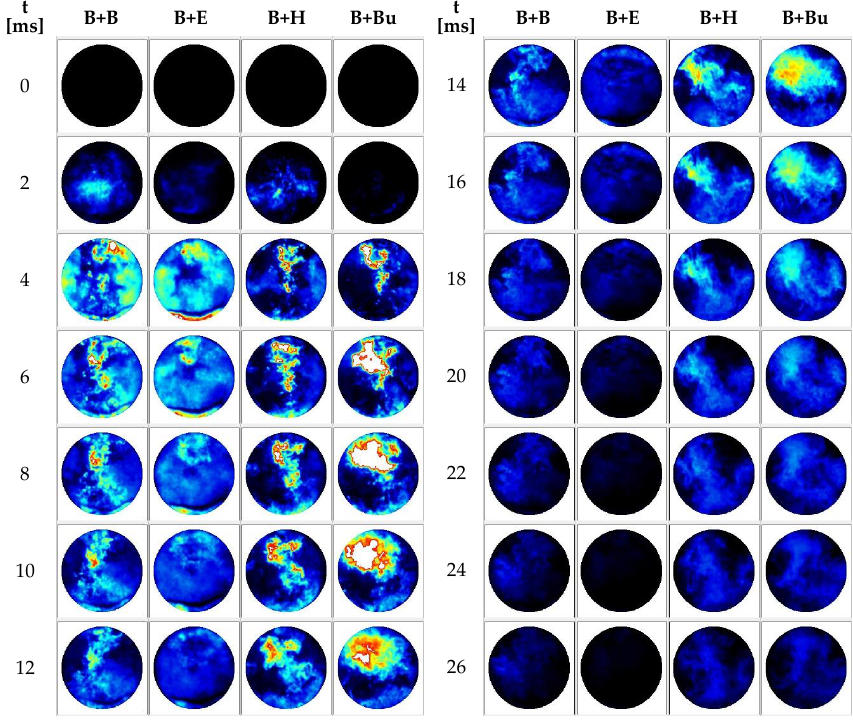
Figure 8. The flame development process recorded during optical experimental tests for various fuel combustion configurations.